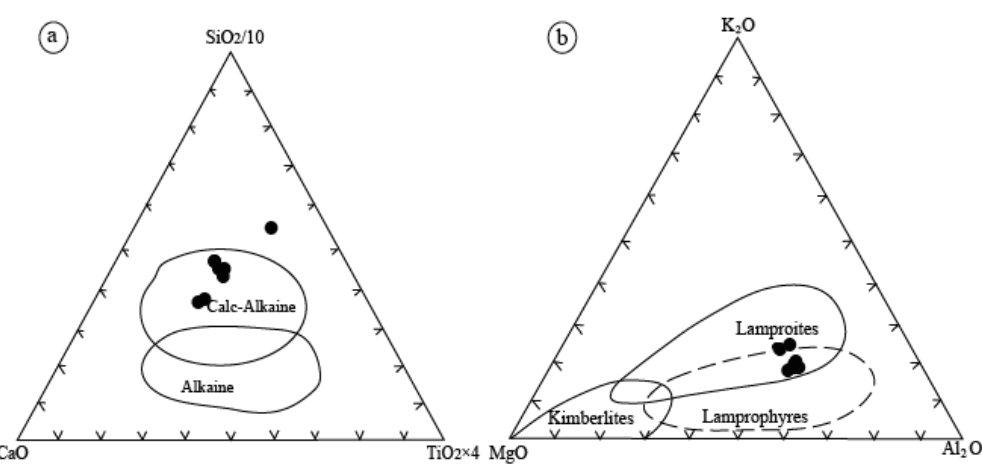
Figure 12. ( a ) Ternary plot of TiO 2 ×4-SiO 2 /10-CaO in which Sungun lamprophyres plot in the calc- calc-alkaline field [37] and ( b ) Ternary plot of K 2 O–MgO–Al 2 O 3 where the study samples plot across the lamproite/lamprophyre fields